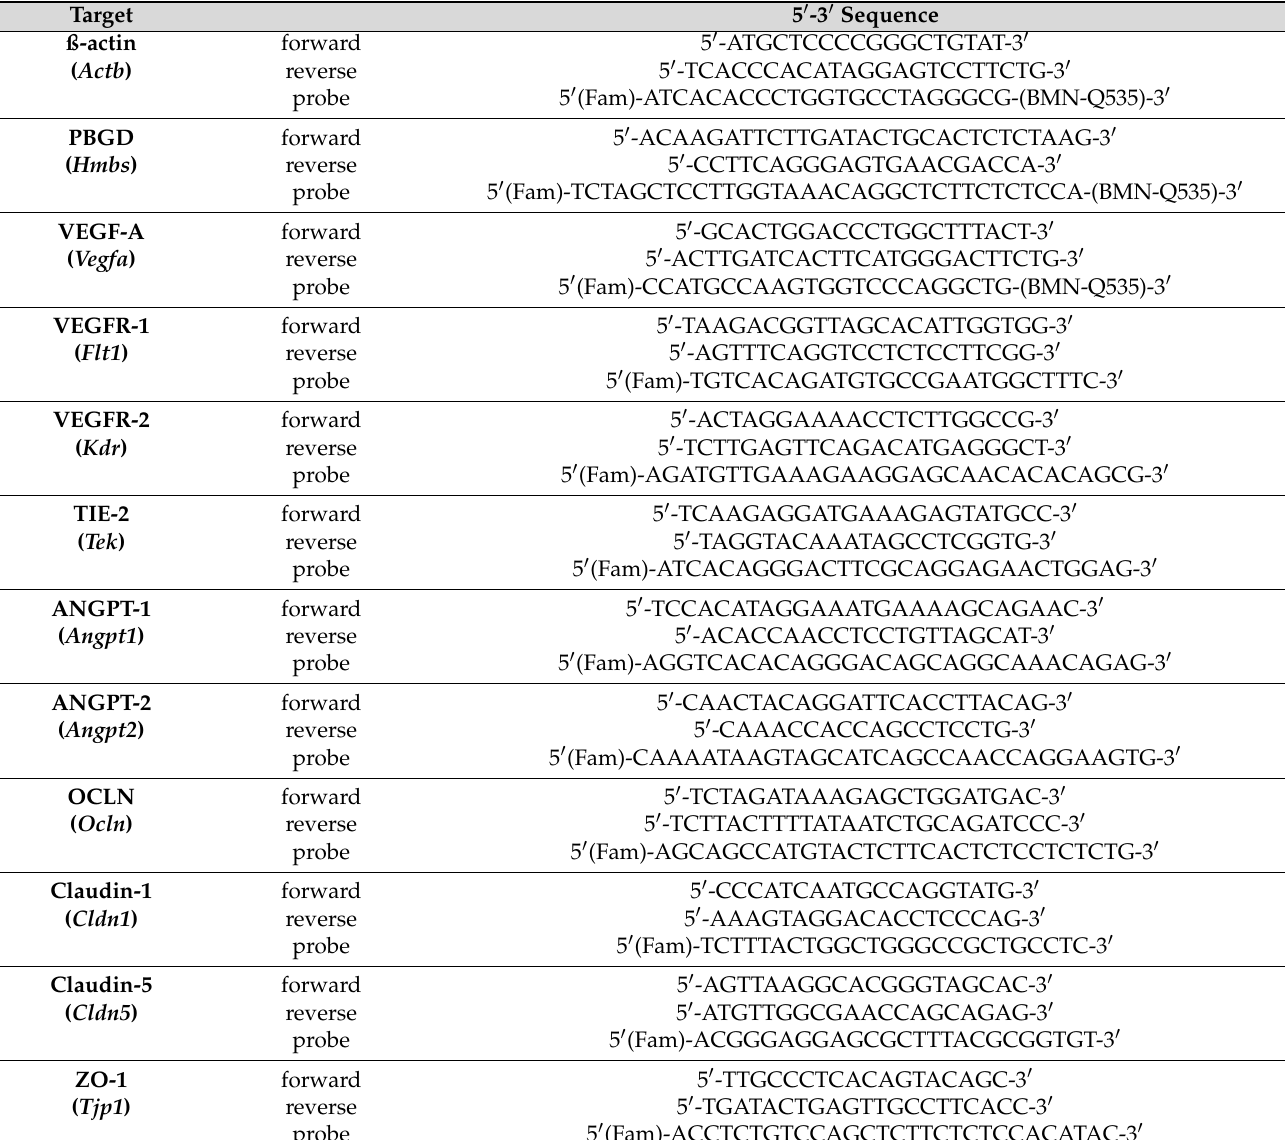
Table 1. qRT-PCR